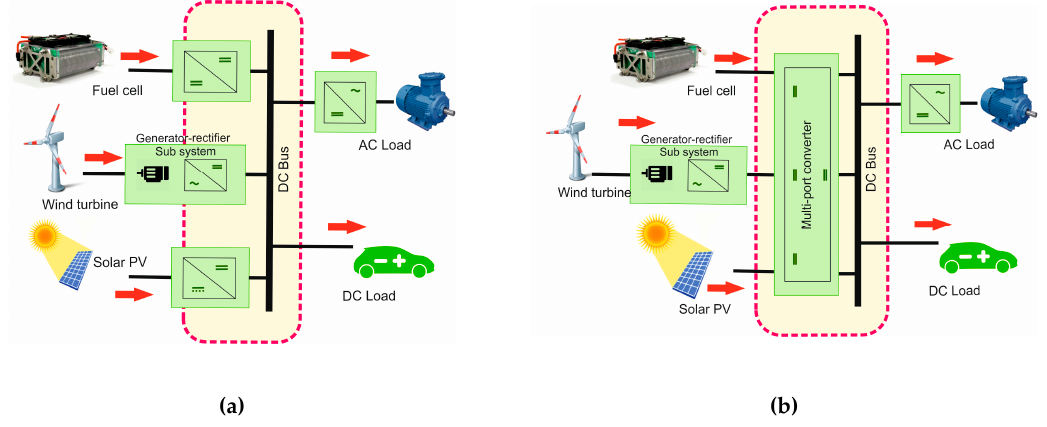
Figure 1. ( a ) Structure of the conventional system, ( b ) Proposed multiport converter (MPC)